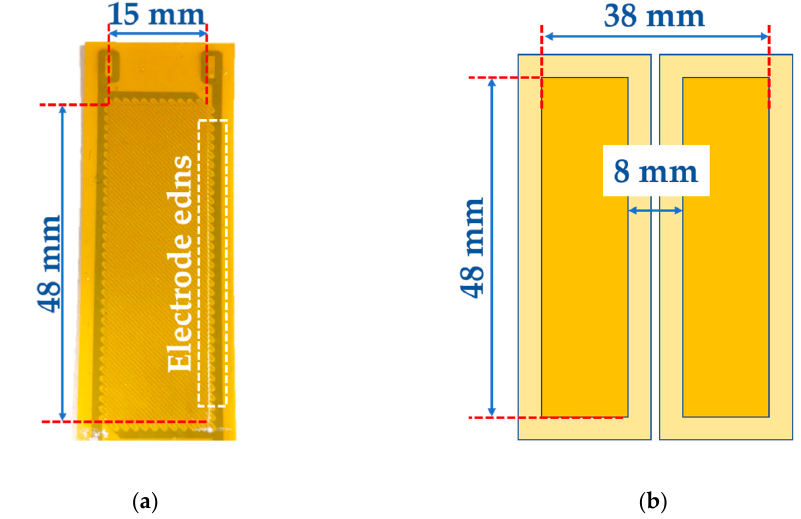
Figure 12. Realization of the dual SHPFP design. ( a ) An actual photo of the commercial PFP (M4815F1, Smart Materials GmbH) that was used to build the dual design. The size of the active area is 48 × 15 mm 2 and the PFP has electrode ends at both of its long edges; ( b ) The configuration of the realized dual SHPFP design. Because of the electrode ends, there is an 8-mm gap between the SHPFP on the left side and the SHPFP on the right side.